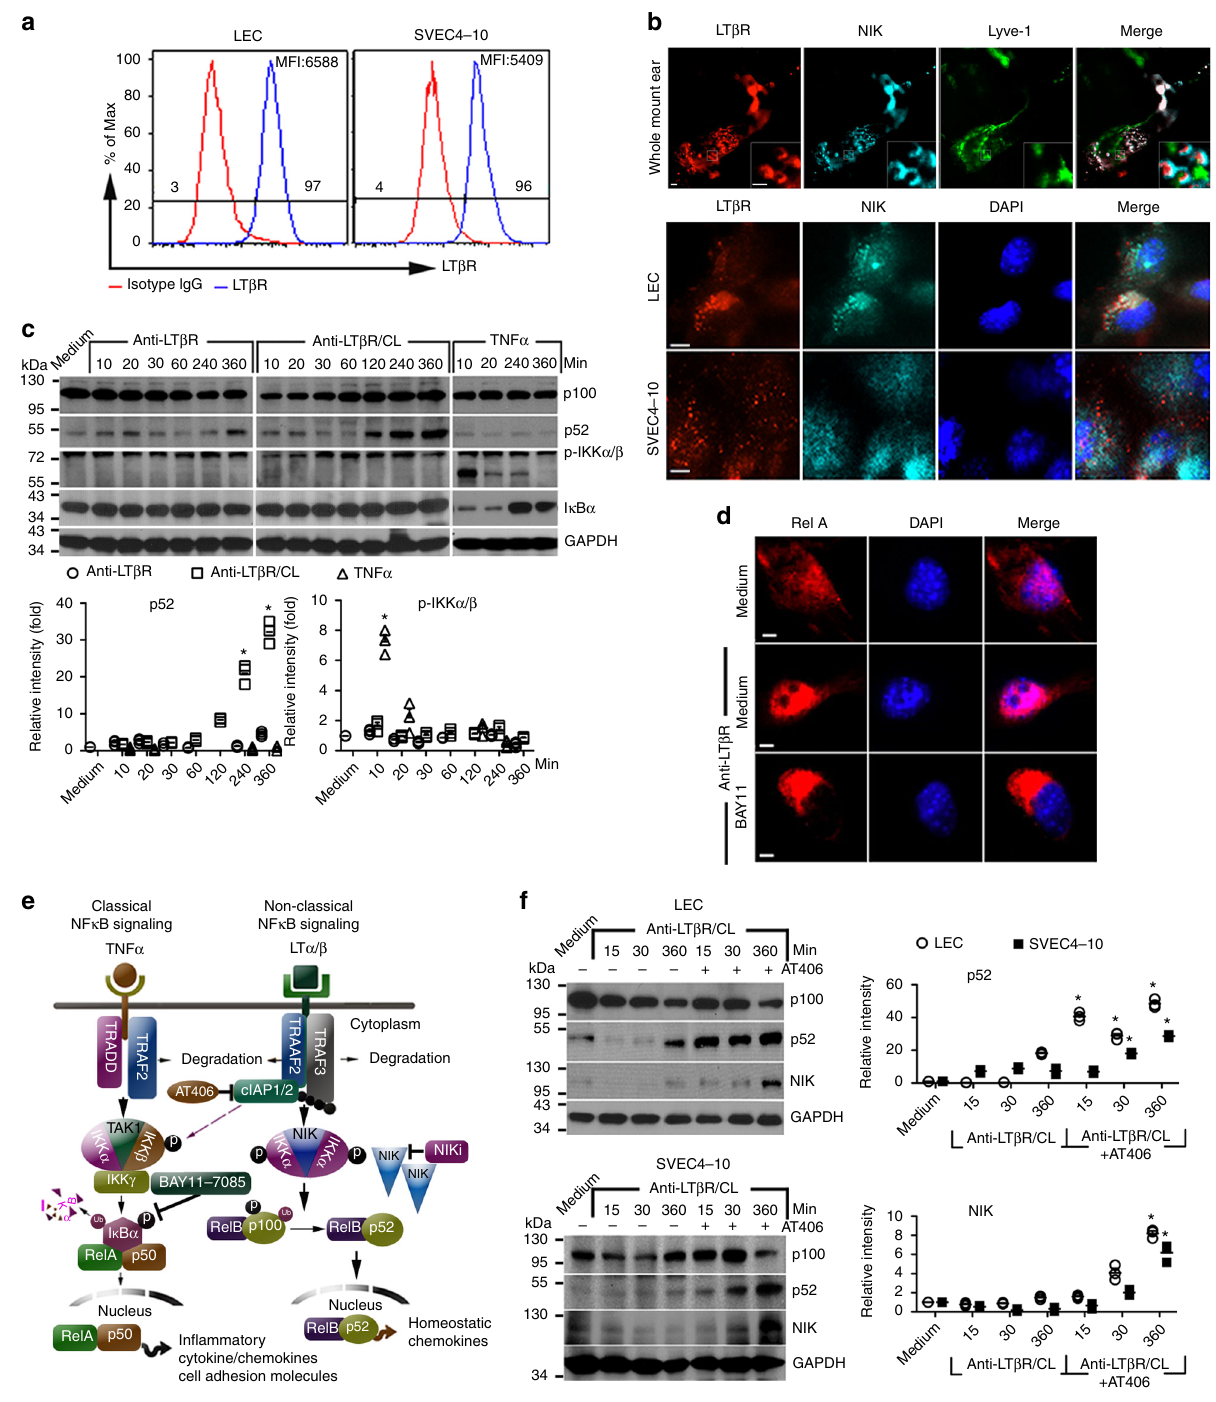
Fig. 1 Preferential non-classical NF κ B signaling induced by LT β R activation in LEC. a Flow cytometry analysis of LT β R expression on murine primary LEC and SVEC4-10. MFI mean fl uorescence intensity. b Immunohistochemistry of LT β R and NIK expression on mouse whole-mount ear, primary LEC, and SVEC4-10. Magni fi cation ×20, ×60 (inset); scale bar 10 μ m. c Mouse primary LEC stimulated with 2 μ g/mL 3C8 anti-LT β R mAb or 20 ng/mL TNF α for the indicated times. For crosslinking (CL), cells incubated with 2 μ g/mL anti-LT β R mAb at 4 °C, washed, and then crosslinked with 2 μ g/mL mouse anti-rat IgG1 for the indicated times. Cell lysates immunoblotted for p100, p52, phosphorylated IKK α / β , I κ B α , and GAPDH. The bar graphs represent the relative band intensities (mean ± SEM) from three independent experiments. * p < 0.05 by one-way ANOVA. d Nuclear translocation of RelA/p65 in LEC stimulated with 2 μ g/mL anti-LT β R for 10 min. Magni fi cation ×60; scale bar 4 μ m. e Diagram of TNF α and LT β R-mediated classical and non-classical NF κ B signaling. f Mouse primary LEC or SVEC4-10 treated as in c , along with 25 μ M AT406. Cell lysates immunoblotted for p100, p52, NIK, and GAPDH. The bar graphs represent the relative band intensities (mean ± SEM) from three independent experiments. * p < 0.05 by one-way